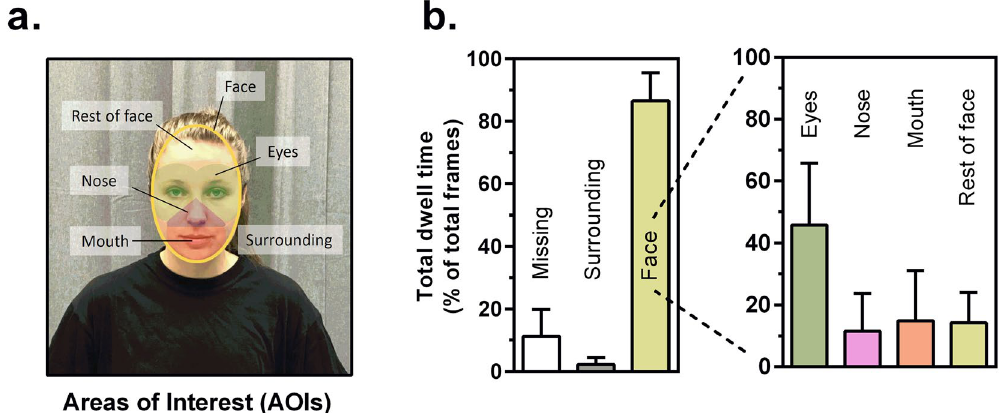
Figure 6. Total dwell time on different facial areas of interest (AOIs) during face-to-face conversation. ( a ) Location and size of AOIs. ( b ) Total dwell time for the face and specific facial areas. Bars represent mean ±